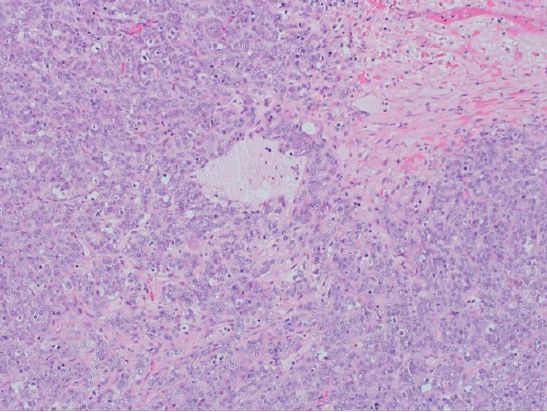
Figure 4. The pathology analysis of the surgical specimen, 100 × . Sheets of tumor cells are interrupted by follicle-like spaces (H&E, 100 ×